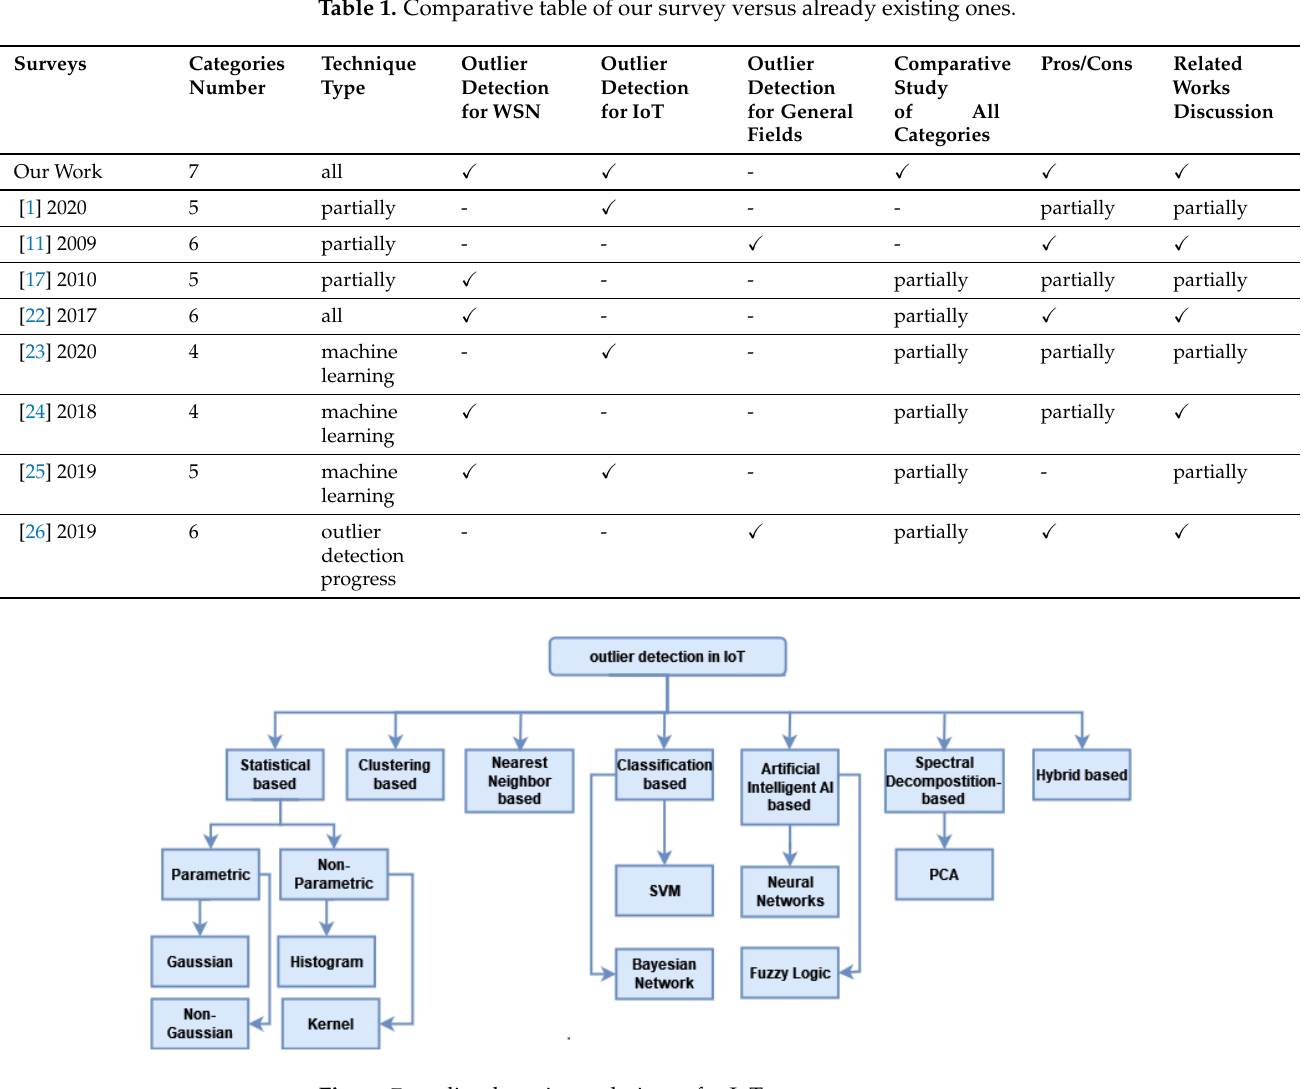
Figure 7. outlier detection techniques for